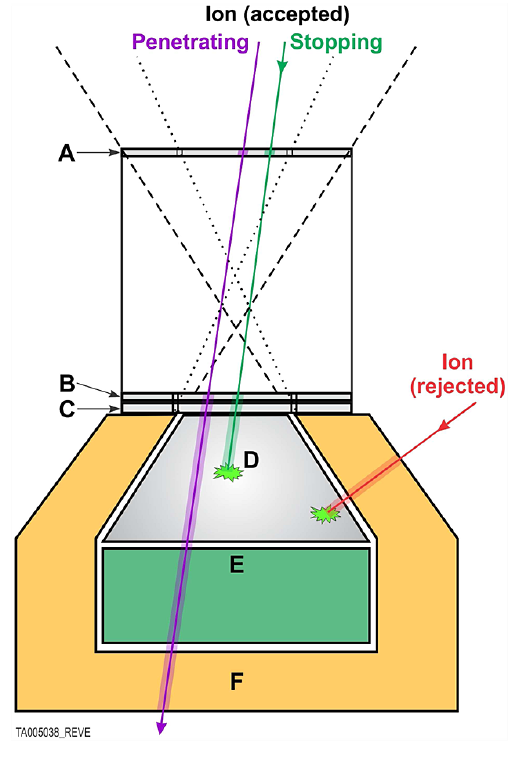
Figure 1. Schematic of the RAD instrument. The detectors A, B, C, D form a telescope for the measurement of charged particles from above. A is segmented in an inner (A2) and an outer (A1) segment, which form two field of view cones, shown by the dashed and dot- ted lines respectively. Stopping charged particles requires a coin- cidence between A2 or A1 and B, and an anti-coincidence with E and F. The green arrow illustrates an example of a stopping charged particle while the red and magenta arrows stand for particles with trajectories that make them unsuitable for the present analysis. Fig- ure is taken from Ehresmann et al. (2014).